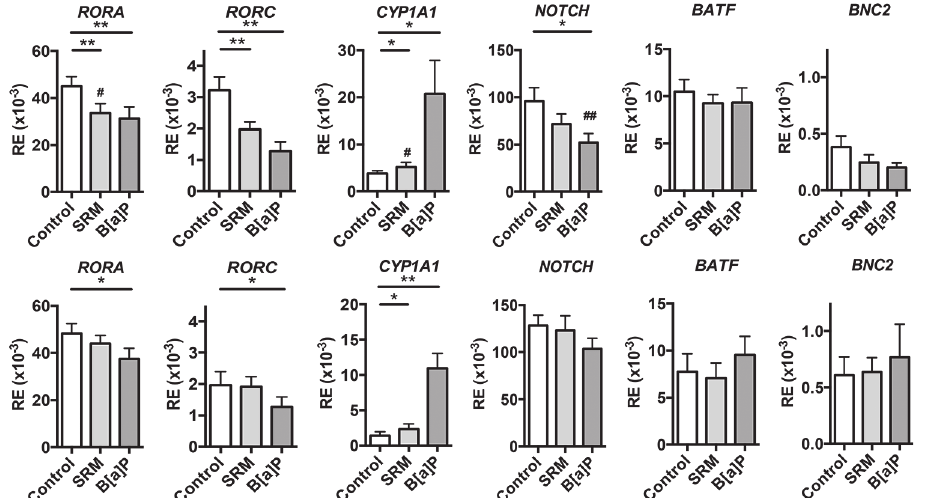
Fig 4. Transcript levels of genes involved in Th17/Th22 polarization. Activated PBMCs from nonallergic (NA) subjects (n = 8) and allergic asthmatic (AA) patients (n = 11) were incubated with or without PAH for 72hr, and gene mRNA level was assessed by Q-RT-PCR. Results are expressed as mean relative expression (RE) of 2^(- Δ Ct) ± SEM, where the Δ Ct value of the sample was determined by subtracting the Ct value of the target gene from the Ct value of the rs9 house keeping gene. * P < .05, ** P < .01, # P < .05 and ## P < .01 AA versus NA subjects.